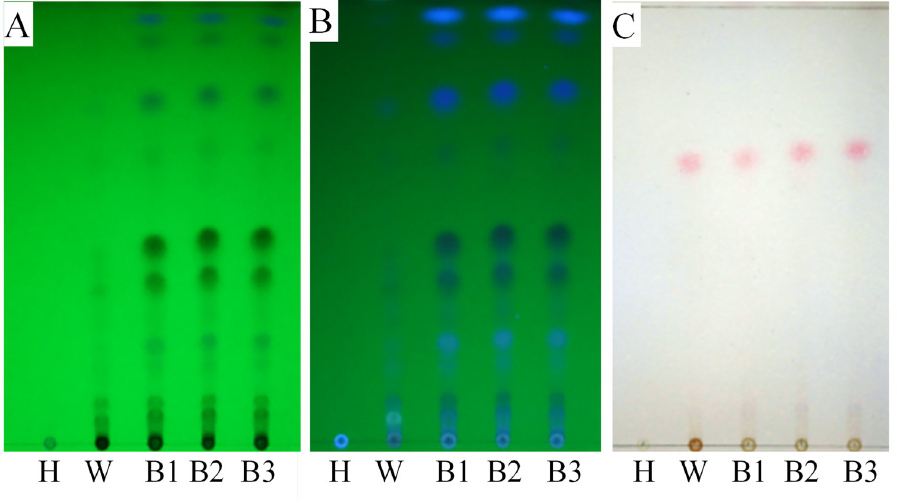
Fig 5. Thin-layer chromatography (TLC) chromatogram of methanol extracts. TLC chromatogram visualized under UV254 nm (A) and UV365 nm (B). (C) Stained and immobilized TLC chromatogram.